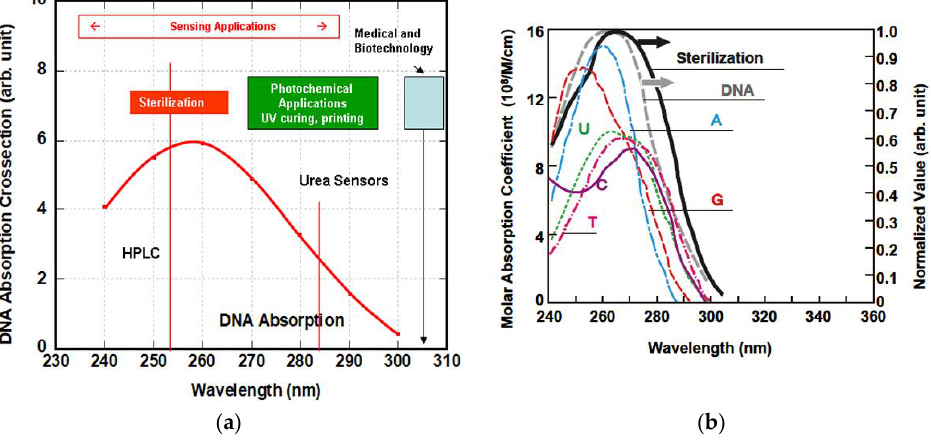
Figure 19. ( a ) Map of application wavelengths for DUV-LEDs; and ( b ) absorption of DNA, AGTC nucleic acids, uracil in ribonucleic acid, and sterilization efficiency related to their absorption. Sensor applications are expected involve various wavelengths. UV light sources in HPLC (254 nm) and urea sensors (285 nm) in a dialyzer are considered as examples. A larger quantity of DUV-LEDs is expected to be used for the applications of sterilization and photochemistry including UV curing. In addition, the weak excitation of proteins is useful for medical and biotechnology applications, where the wavelength used is between 305 and 315 nm. (( a ) Permitted to be reproduced from Oyobutsuri [22] (© Japan Society Applied Physics) and ( b ) is reproduced from Hikari Alliance [150].).